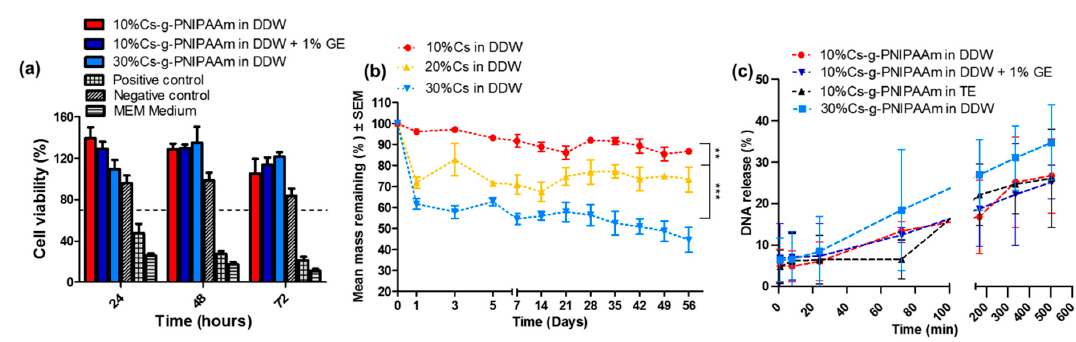
Figure 7. ( a ) Cell viability analyzed via MTS assay for NCTC L929 fibroblasts co-cultured for 24 h with the hydrogel degradation products for 10%, 10% crosslinked with GE, and 30% Cs in relation to NIPAAm. The dashed line delineates 70% viability, below which is deemed cytotoxic, as designated by the ISO 10993–5 [35]. ( b ) Degradation profile of Cs-g-PNIPAAm in DDW over eight weeks. ( c ) Release profiles of RALA / pEGFP-N1 NPs) from 5% w / v 10% Cs and 30% Cs-g-PNIPAAm hydrogels in DDW at 37 °C. Values represent mean ±SEM (n = 3).